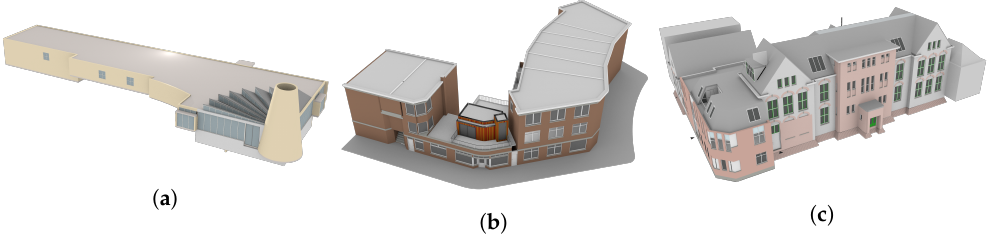
Figure 3. Test IFC files from the City of The Hague. ( a ) CUVO Ockenburghstraat KOW; ( b ) Rabarberstraat 144; ( c ) Witte de Withstraat.